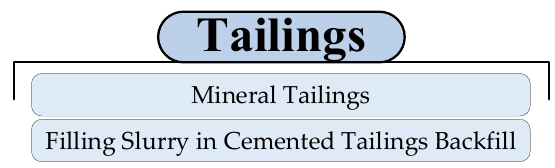
Figure 7. The studied subsections of tailings.